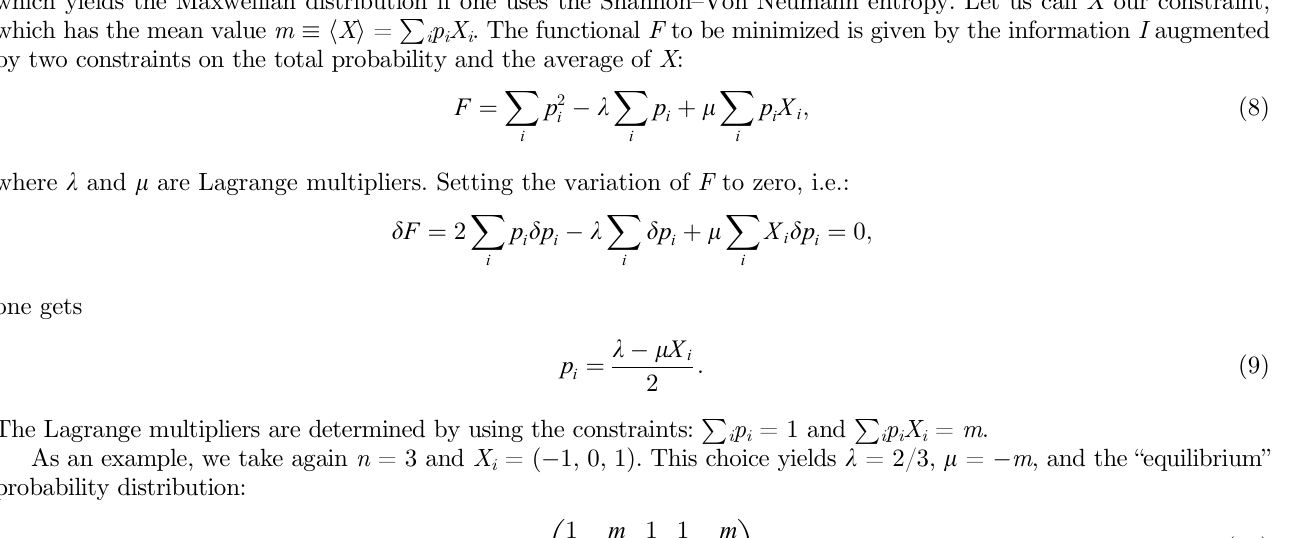
Figure 2. Schematic representation of the case n = 3. (a) The solutions of equations (6) and (7) lie on the circle given by the intersection of the sphere of radius R (here represented for the pure state with R = 1) and the plane p passing through the points A, B and C. The dashed triangle ABC, lying on the plane p , has all sides equal to a ¼ (b) View of the plane p with the circumscribed and inscribed circles of radii r e and r i , which correspond, respectively, to values R = 1 ffiffiffi p and R ¼ 1 = 2 . The thin red circle is an intermediate case where positive and negative probabilities coexist (the latter lie outside the triangle). (c) Circular cone with apex at the origin O and basis circle of radius r i . The height k of the cone is the distance between the origin and the plane p